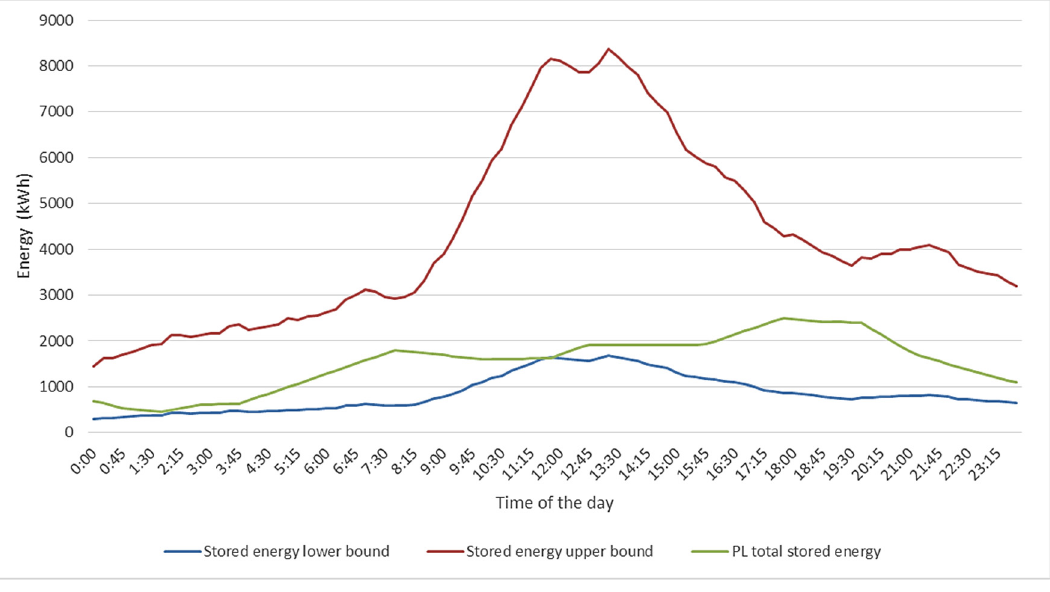
Figure 18. Total energy stored in EVs’ batteries, and respective upper and lower